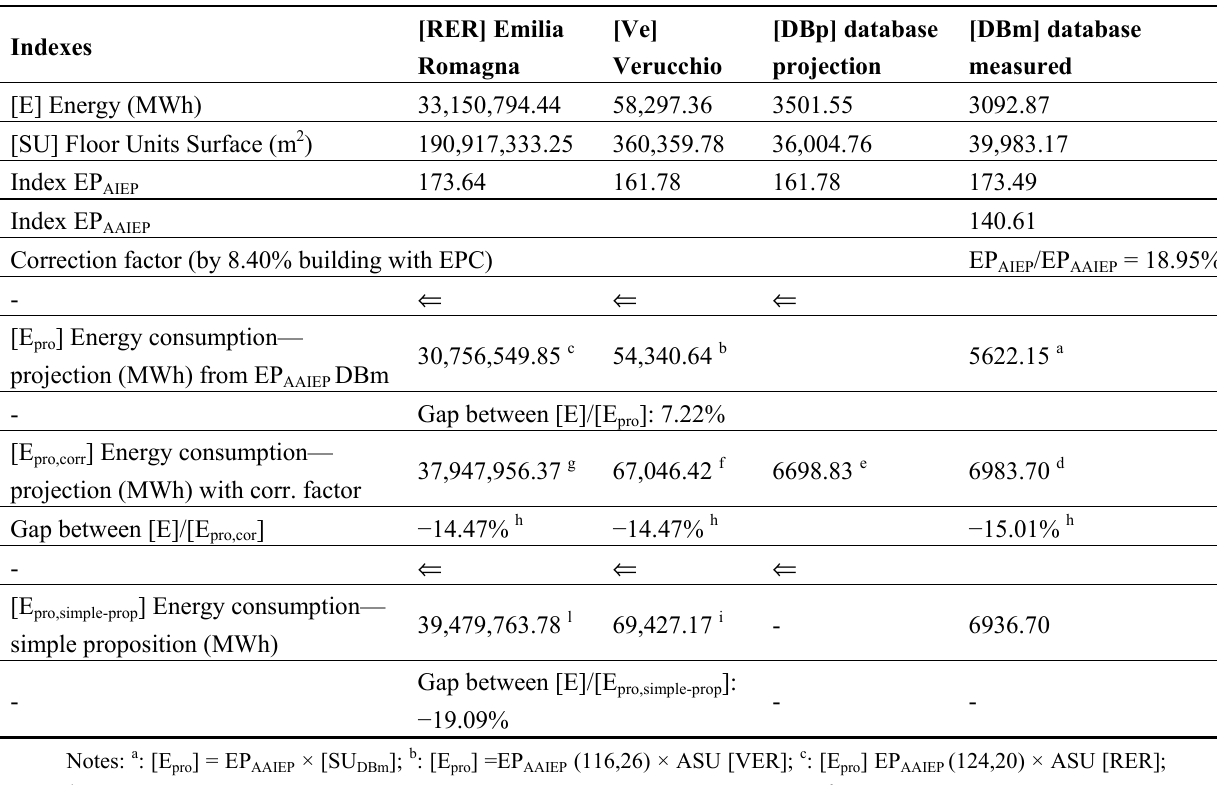
Table 18. Database 2011: bottom-up to top-down